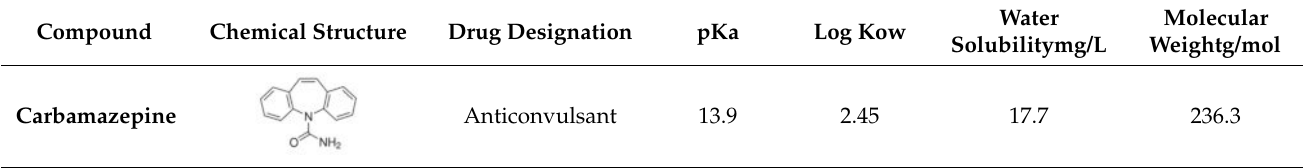
Table 1. Classification and physical and chemical properties of